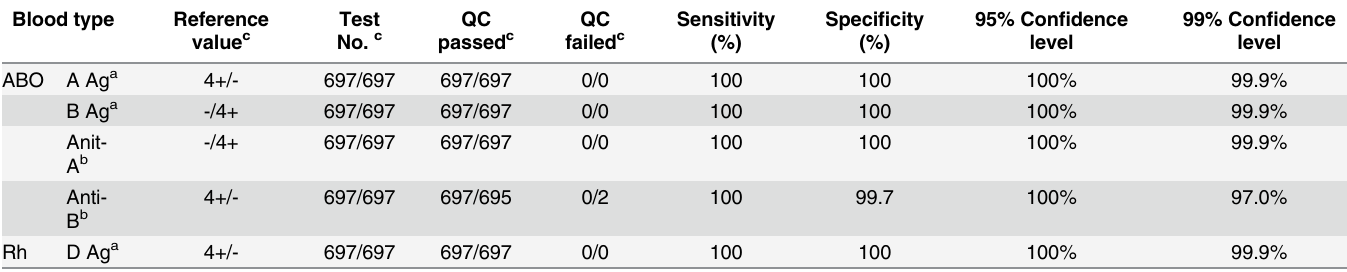
a Blood group antigens for forward blood typing. b Blood group antibodies for reverse blood typing. c